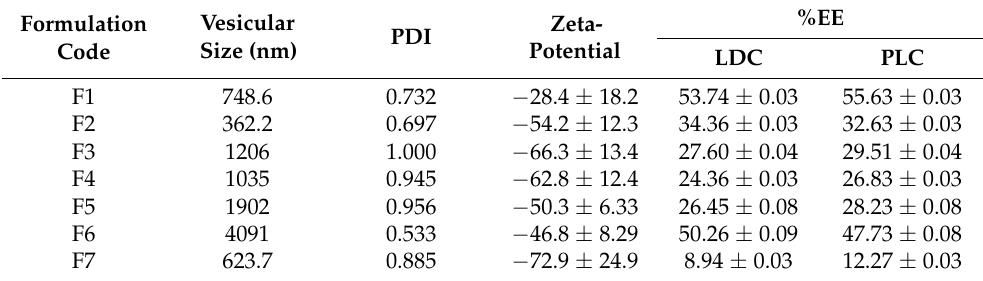
Table 1. Niosome encapsulated lidocaine and prilocaine percentage of entrapment efficiency (%EE), particle size (nm), zeta potential (mv), and polydispersity index (PDI). %EE Vesicular Zeta- Formulation PDI Size (nm) Potential Code LDC PLC F1 748.6 0.732 − 28.4 ± 18.2 53.74 ± 0.03 55.63 ± 0.03 F2 362.2 0.697 − 54.2 ± 12.3 34.36 ± 0.03 32.63 ± 0.03 F3 1206 1.000 − 66.3 ± 13.4 27.60 ± 0.04 29.51 ± 0.04 F4 1035 0.945 − 62.8 ± 12.4 24.36 ± 0.03 26.83 ± 0.03 F5 1902 0.956 − 50.3 ± 6.33 26.45 ± 0.08 28.23 ± 0.08 F6 4091 0.533 − 46.8 ± 8.29 50.26 ± 0.09 47.73 ± 0.08 F7 623.7